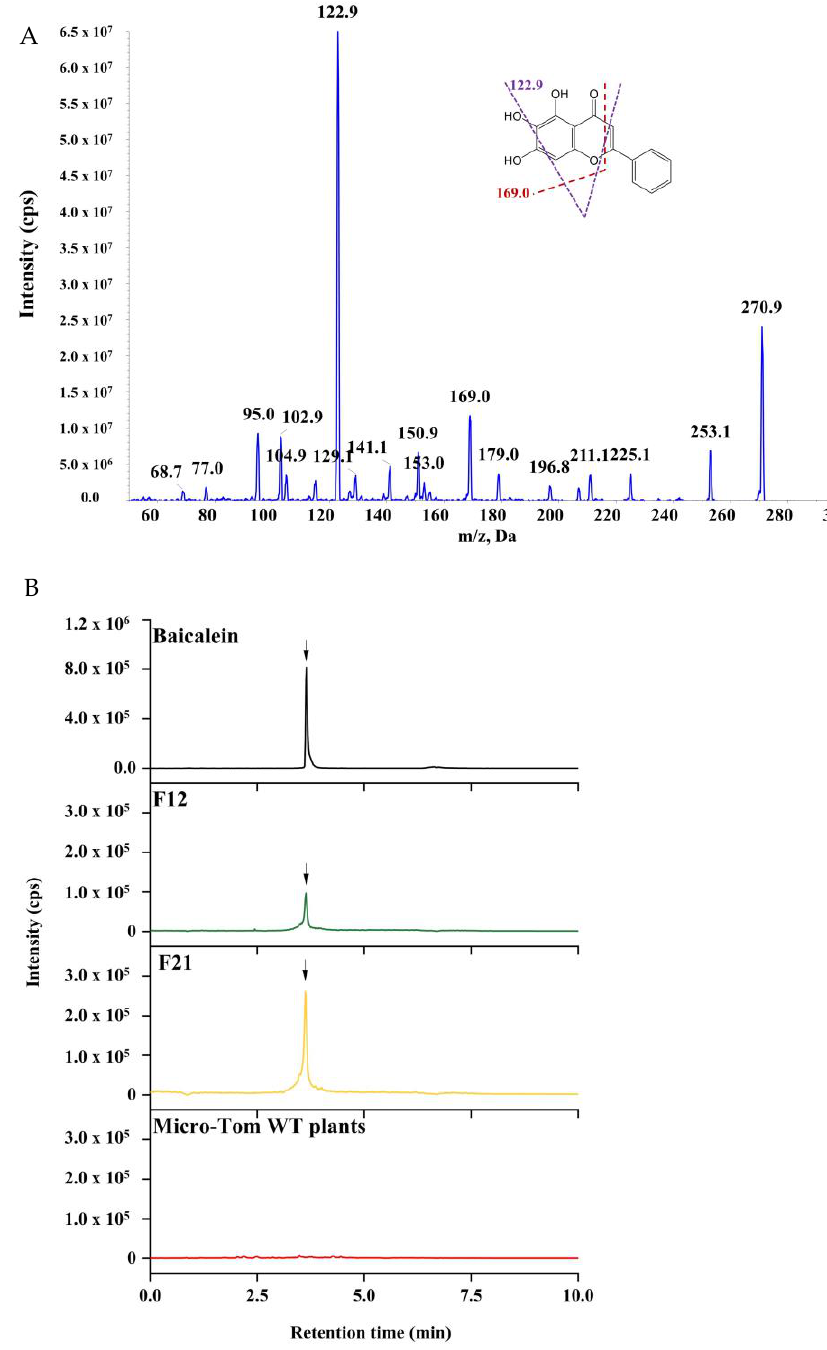
Figure 4. HPLC-MS/MS analysis of baicalein in transgenic Micro-Tom tomato lines. ( A ) Full-scan product ion spectra and the proposed fragmentation schemes of baicalein. ( B ) The total ion chromatogram (TIC) of the samples and the control, respectively.